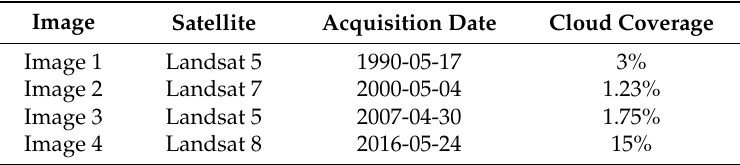
Table 1. Acquired satellite images of study